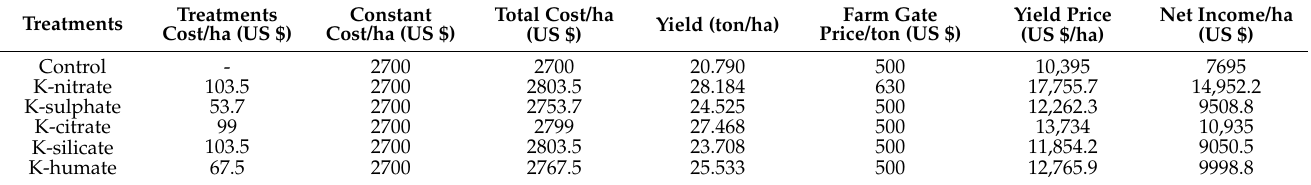
Table 11. Net income of foliar application of potassium